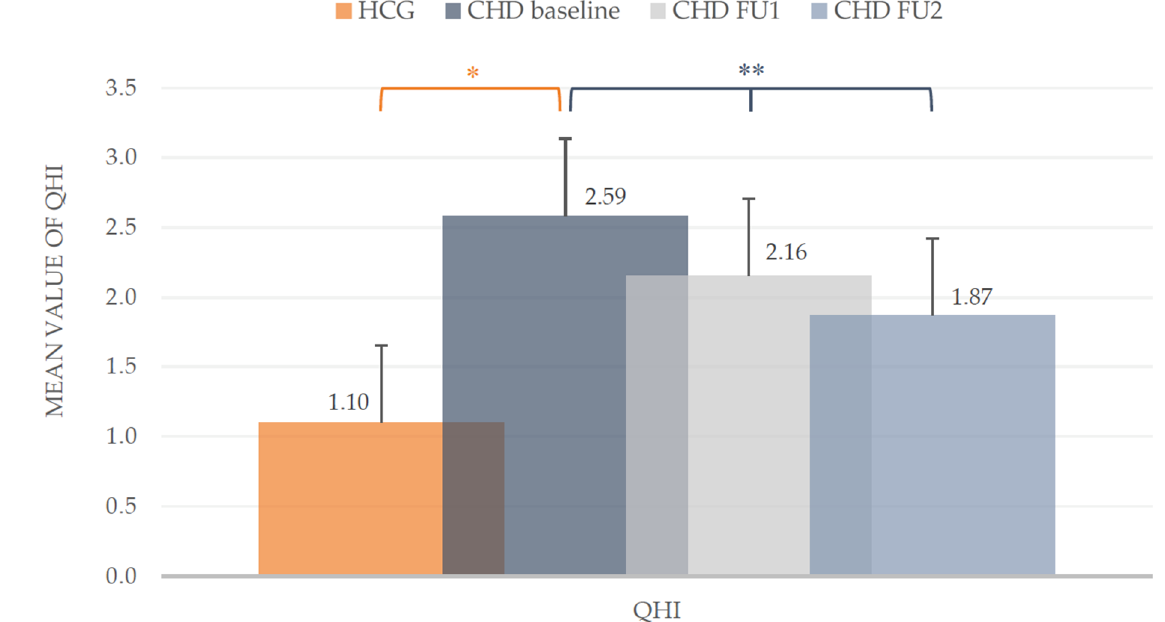
Figure 2. Quigley/Hein Plaque Index (QHI). Mean values including standard deviation of the intervention group (CHD) and healthy control group (HCG) at baseline and during the two follow-ups (FU1 and FU2) of the CHD group. * Mann-Whitney-U test ( p < 0.05), ** t -test ( p < 0.05).